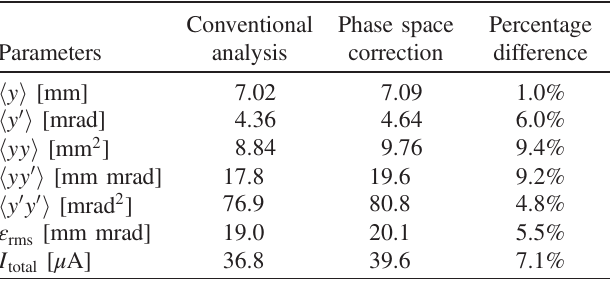
TABLE VII. Solution of Eq. (11) for the quadrupole scan in Sec. IV B, with measurement results x tional and improved analysis method,